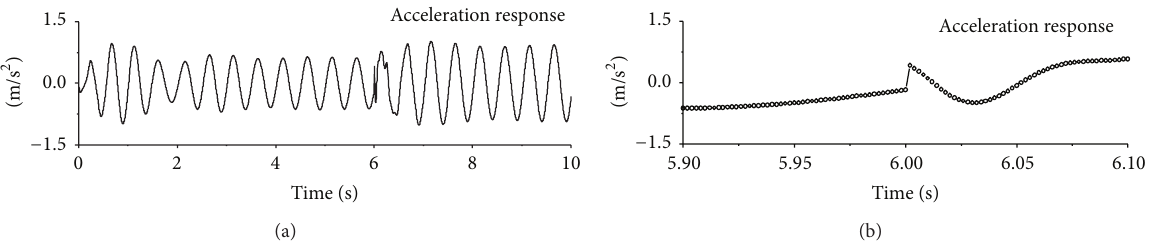
Figure 3: Signal discontinuity due to sudden damage (sinusoidal excitation).